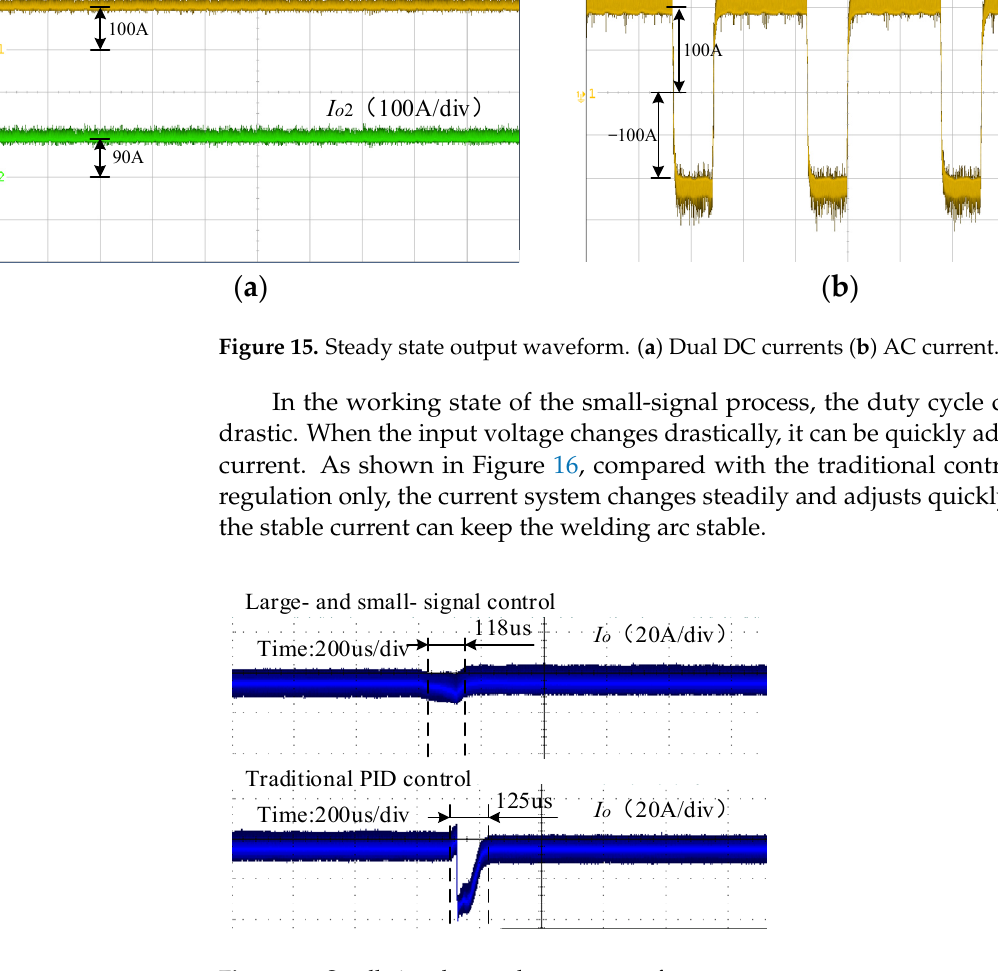
Figure 16. Small-signal control output waveform.